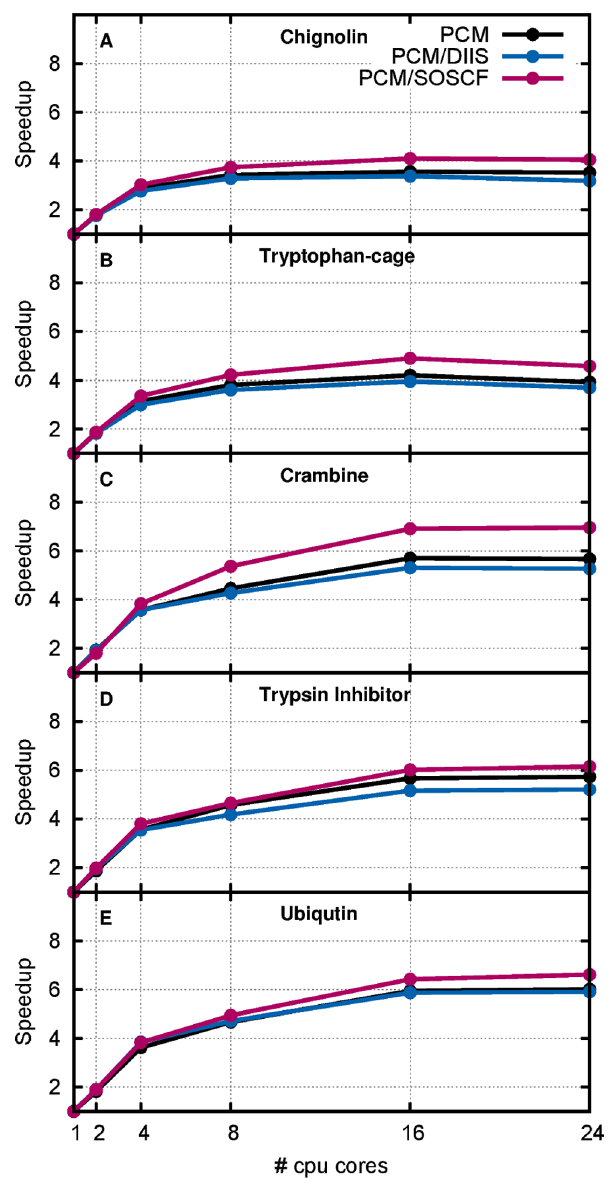
Figure 1. Speedup by using multiple cores with PCM enabled for single gradient